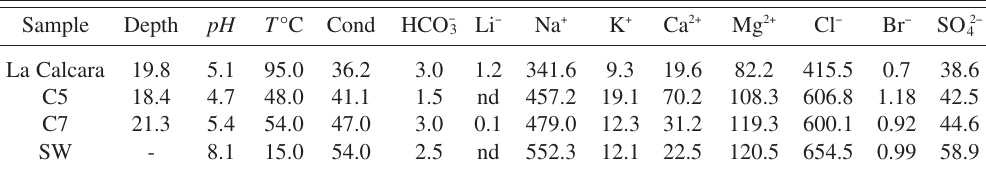
Table III. Chemical composition of the thermal water samples in comparison with local seawater (SW). The depth of the sampling site is reported in meters, conductivity in mS/cm and concentrations in mEq/l. nd = below the detection limits.